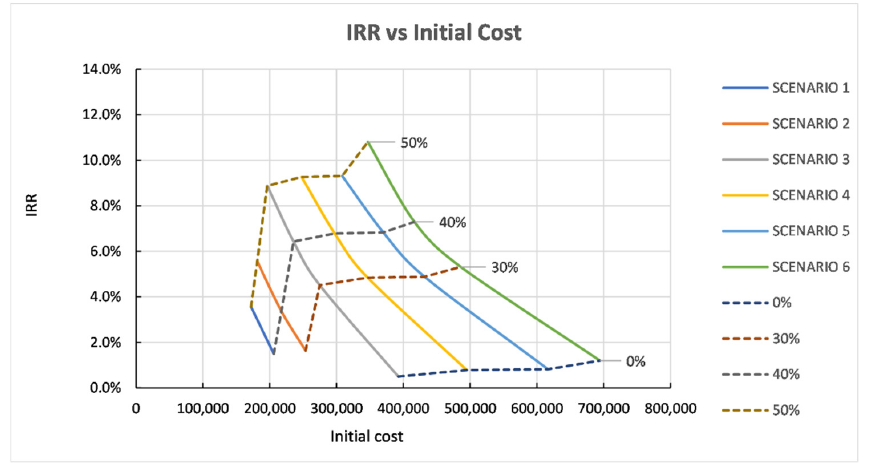
Figure 13. Effect of subsidy to IRR and the initial cost of the HRS.